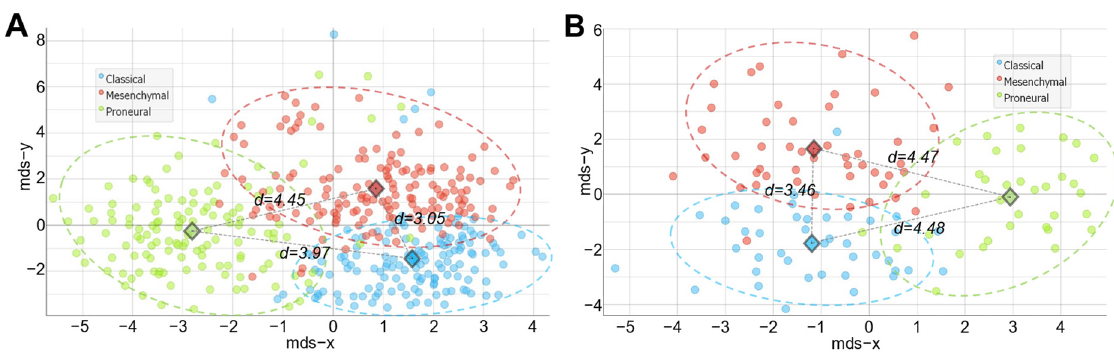
Figure 3. Multidimensional scaling (MDS) analysis applying 20 selected subtyping genes. The distance visualization of the Affymetrix HT cohort cases ( A ) and Illumina HiSeq cohort cases ( B ). Diamonds indicate centroids of each subtype (plotted in two-dimensional space) and values (d) next to the grey dashed line, which indicates the Euclidean distance between the subtype centroids.